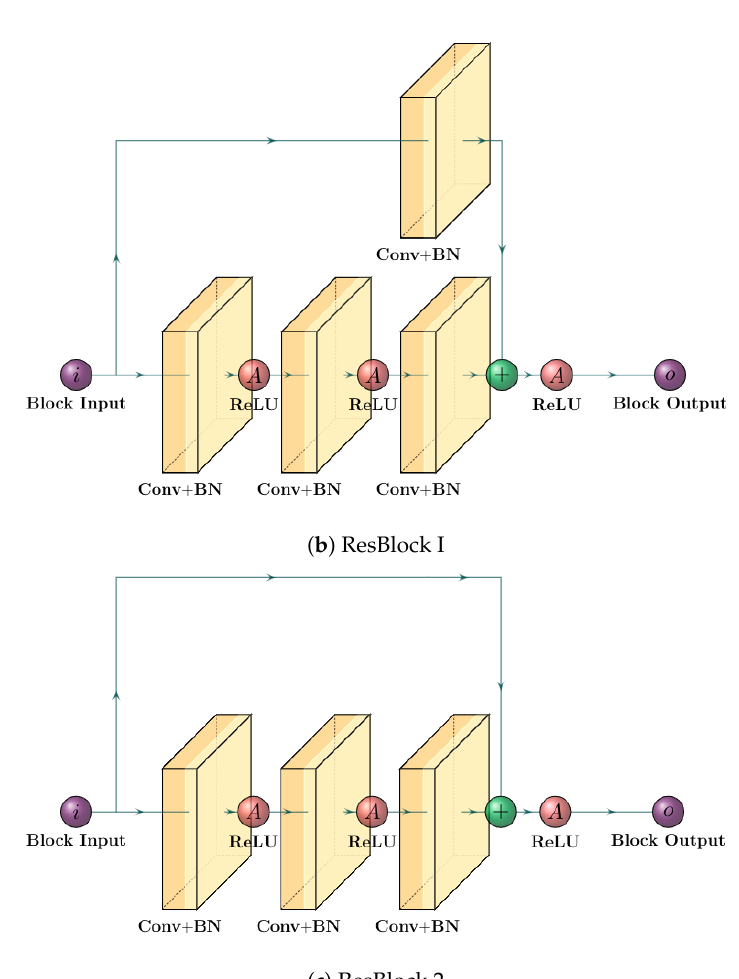
Figure 4. Example ResNet architecture for formation identification—once the player locations are known, we use a ResNet to determine the player labels; ( a ) is the base architecture, ( b ) is Res I, and ( c ) is Res